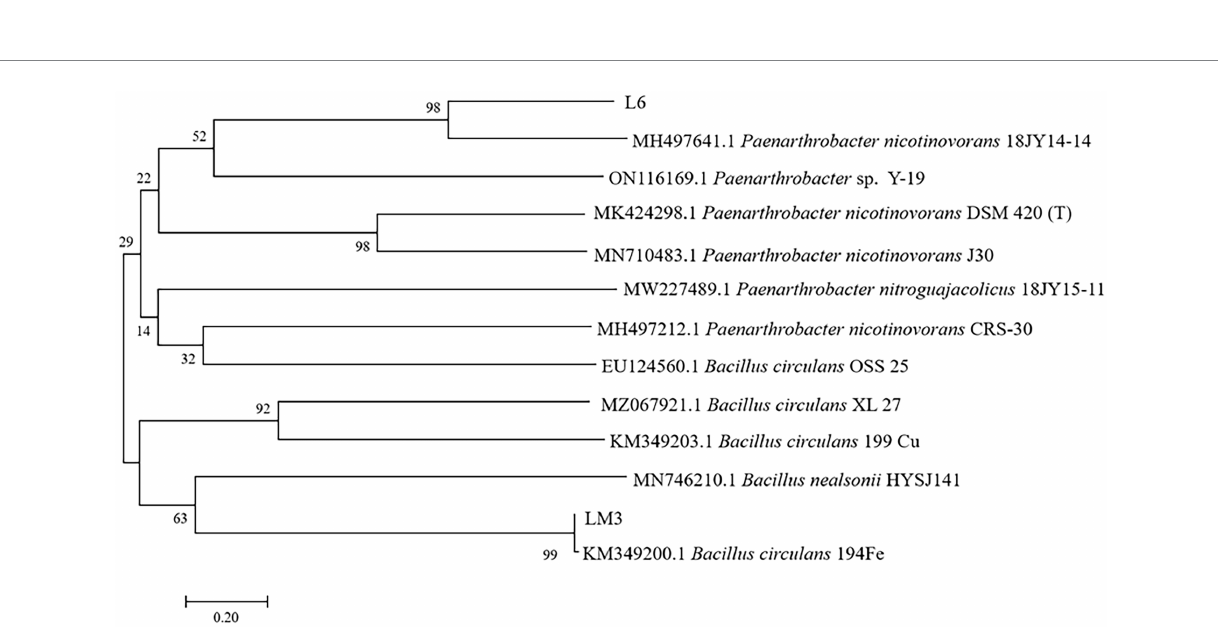
FIGURE 5 Neighbor-joining phylogenetic tree based on the 16S rDNA sequence data of potential MHB strains L6 and LM3 isolated from Vaccinium uliginosum rhizosphere soil. Numerical values above the branches indicate the bootstrap percentiles from 1,000 replicates. Bootstrap numbers higher than 50% are indicated. Horizontal branch lengths are proportional to the scale of the